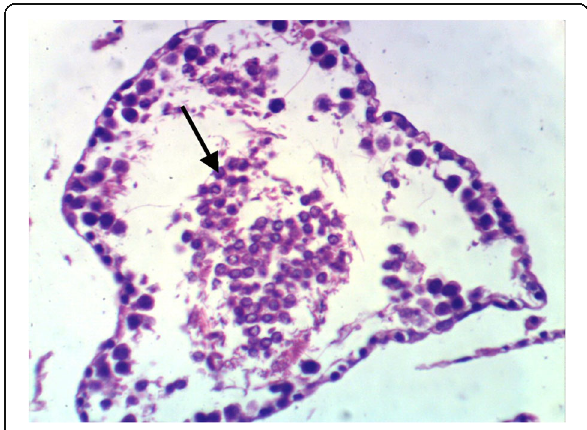
Fig. 1 Photomicrograph of rat ’ s testis of the potbromate -treated group showing testicular damage and